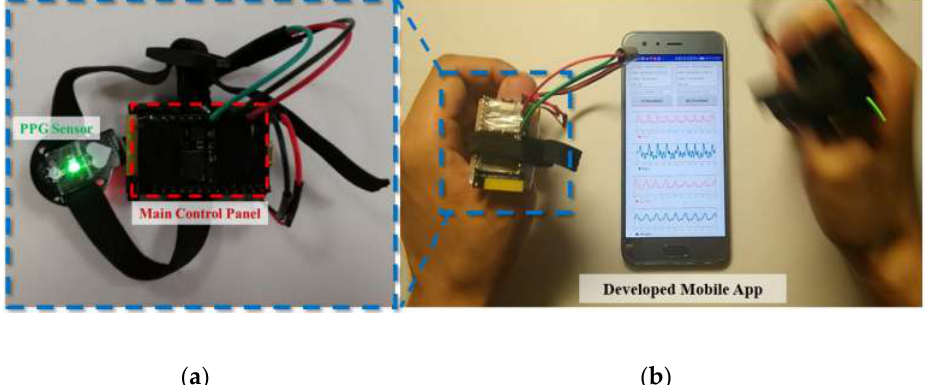
Figure 8. The developed PPG evaluation platform: ( a ) the signal acquisition finger-band system consisting of the PPG sensor and main control panel; ( b ) demonstration of the developed platform: the subject will wear the finger-band on both hands of them, with the left hand stationary and the right hand moving.